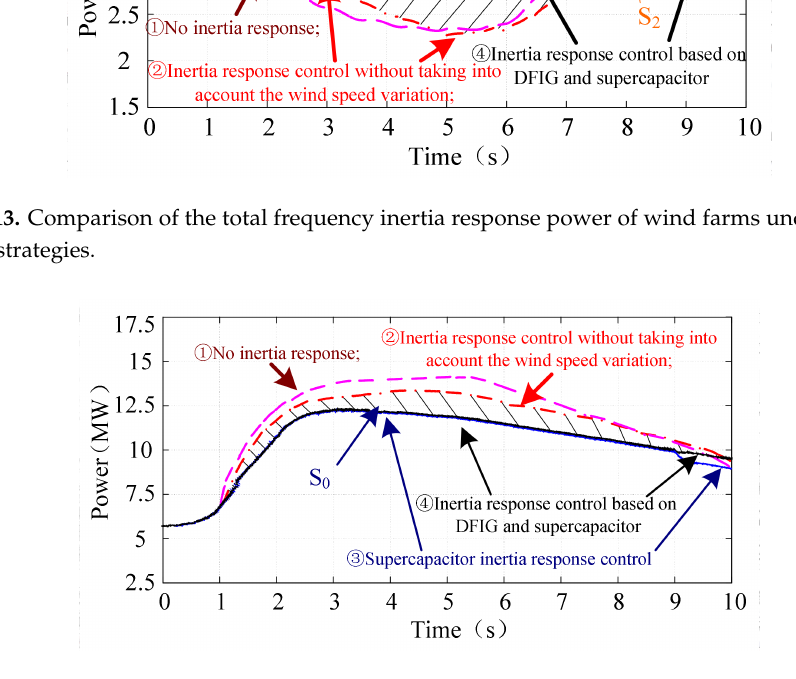
Figure 14. Comparison of the power of SG under different control